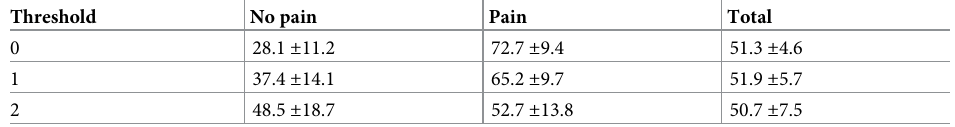
Table 8. Accuracies (%) from the expert baseline, varying with the chosen pain